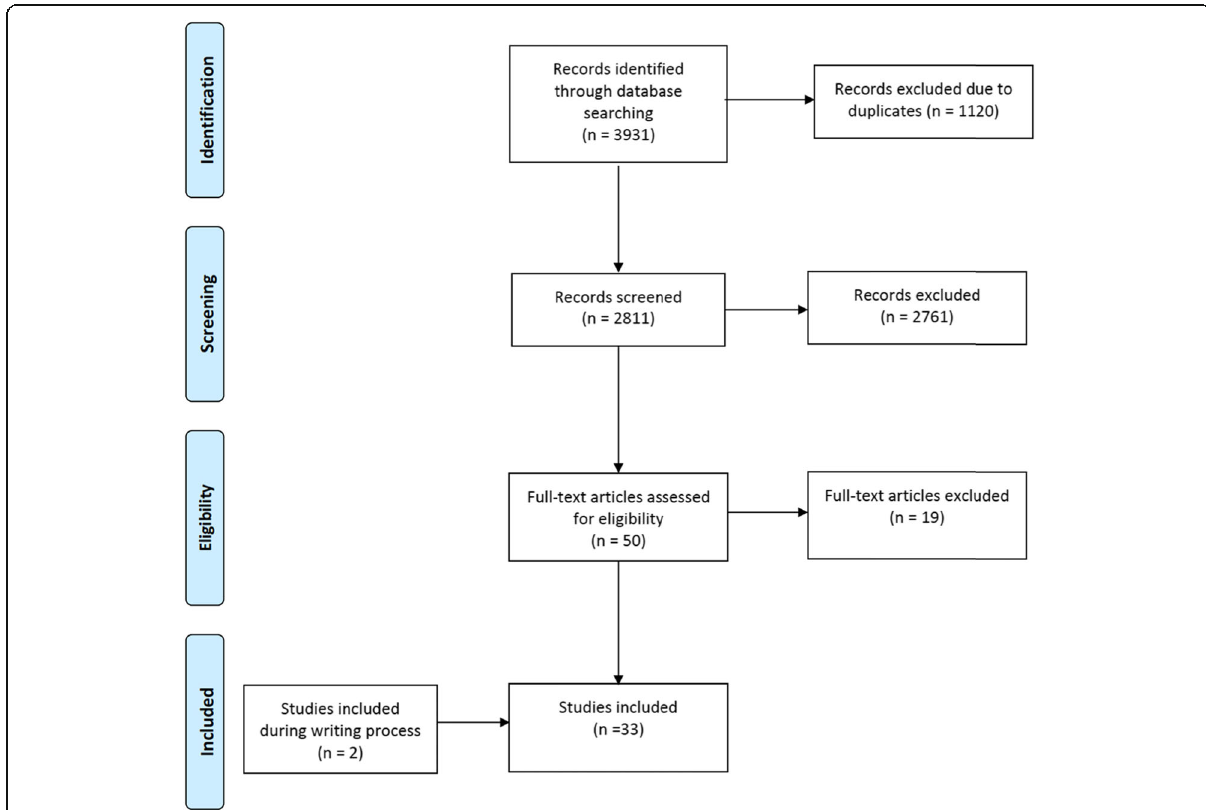
Fig. 2 PRISMA flowchart of the review process of our